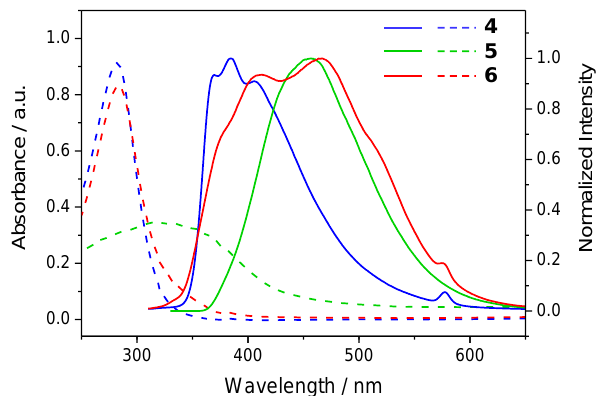
Figure 7. Absorption (dashed lines) and photoluminescence (solid lines) spectra of microcrystals of 4 – 6 . Excitation wavelength: 280 nm for 4 and 6 ; 315 nm for 5 .